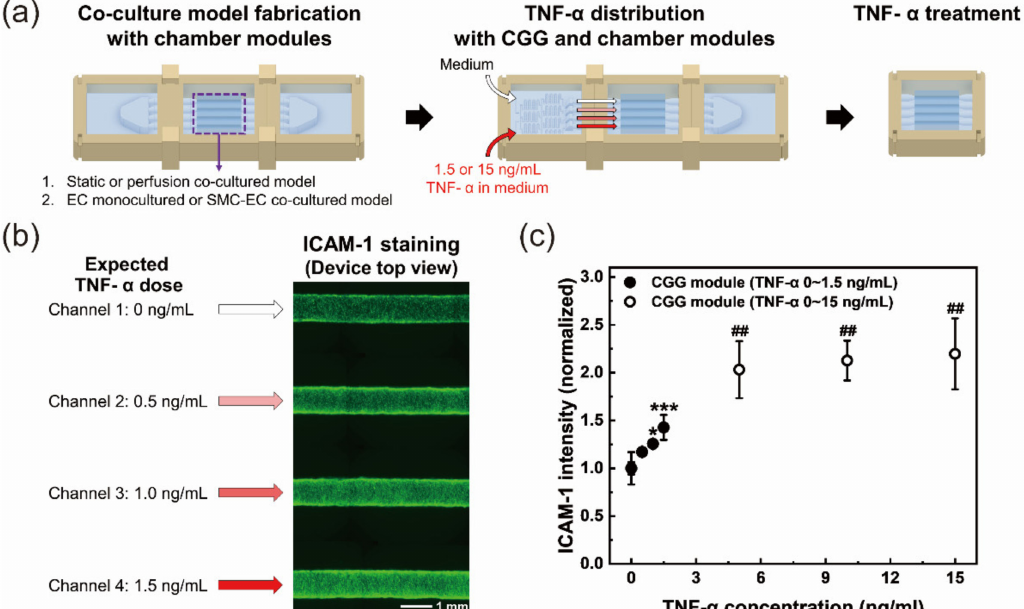
Figure 5. Tumor necrosis factor (TNF)- α dose-dependent inflammation model. ( a ) Experimental procedure for the inflammation model. A coculture model was fabricated with chamber modules. Static vs. perfusion coculture conditions and EC monoculture vs. SMC–EC coculture were compared. ( b ) Intercellular adhesion molecule 1 (ICAM-1) fluorescence staining images in different channels. Based on the CGG module performance, TNF- α concentrations applied to each channel in a multichannel device were estimated, and ICAM-1 expression in the models was immunofluorescence-stained and observed. ( c ) The ICAM-1 intensity of four channels in a device with one inlet TNF- α concentration of 1.5 or 15 ng/mL. Since the channel diameter was large and the whole diameter was not included in the depth of focus, we analyzed only the area of 70% of the center of the channel width, excluding the channel edge part. * p < 0.05, *** p < 0.001 vs. no treatment channel with 1.5 ng/mL inlet TNF- α ; ## p < 0.01 vs. no treatment channel with 15 ng/mL inlet TNF- α . All n = 3 independent